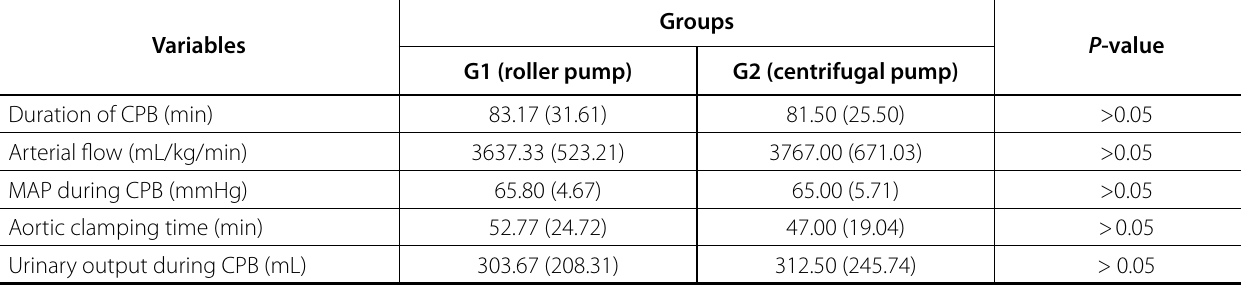
Table 2. Mean (standard deviation) CPB-related variables, stratified by group.